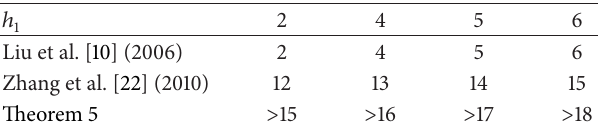
Table 1: Comparison of the maximum allowed time delay ℎ 2 for different conditions.